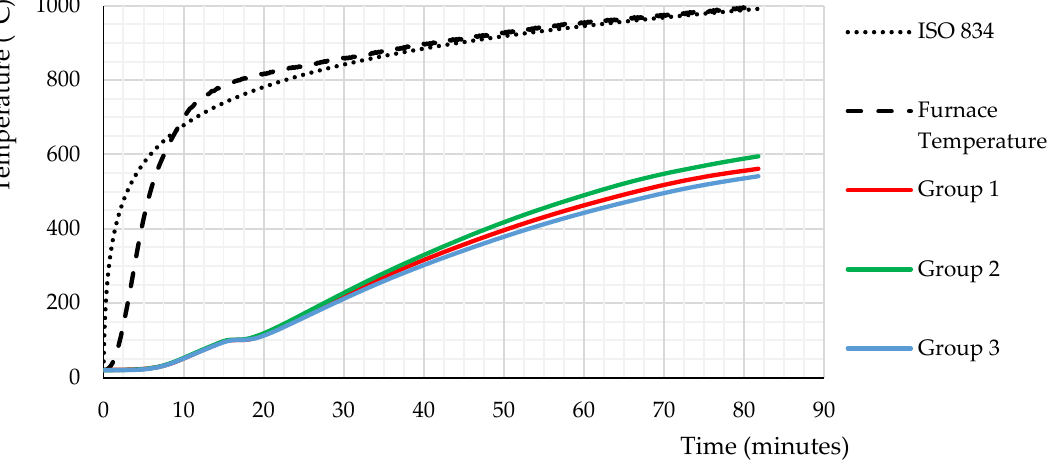
Figure 10. Evolution of the average temperature in the three groups of thermocouples in specimen 5 of SSC.